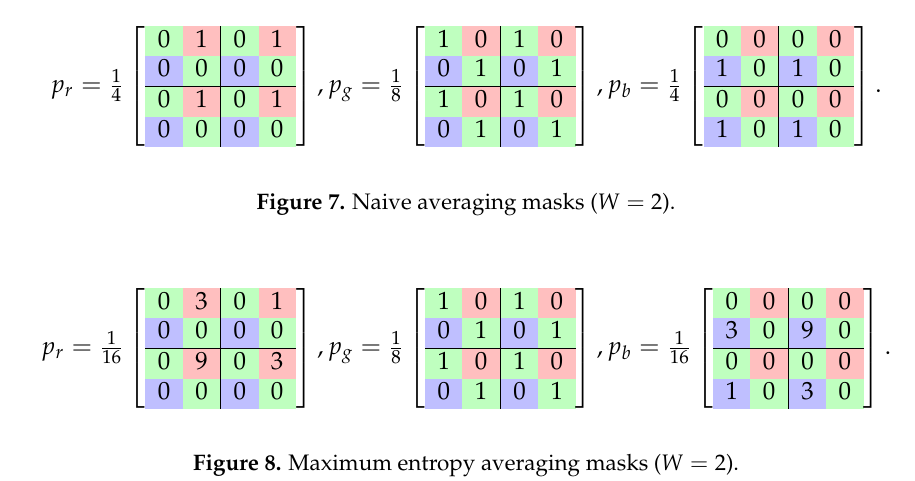
Figure 8. Maximum entropy averaging masks ( W =